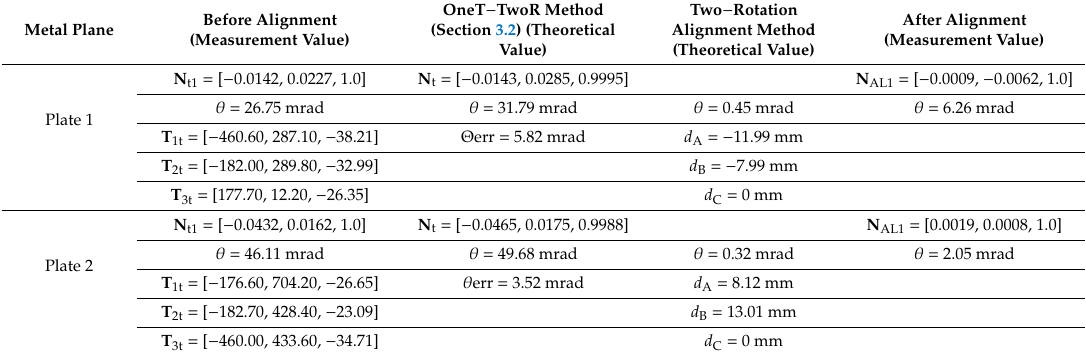
Table 4. Experimental results of the facet alignment of the metal plane using the two-rotation alignment